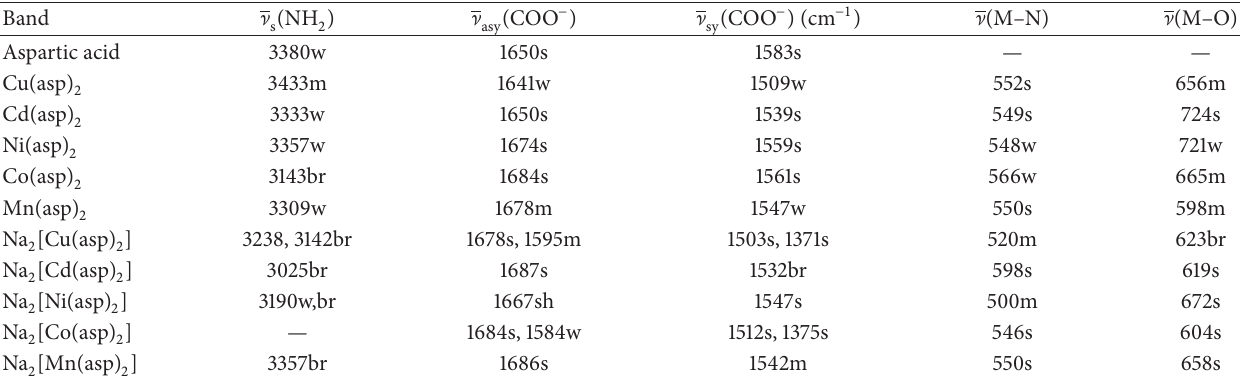
Table 3: Relevant IR bands for the compounds.